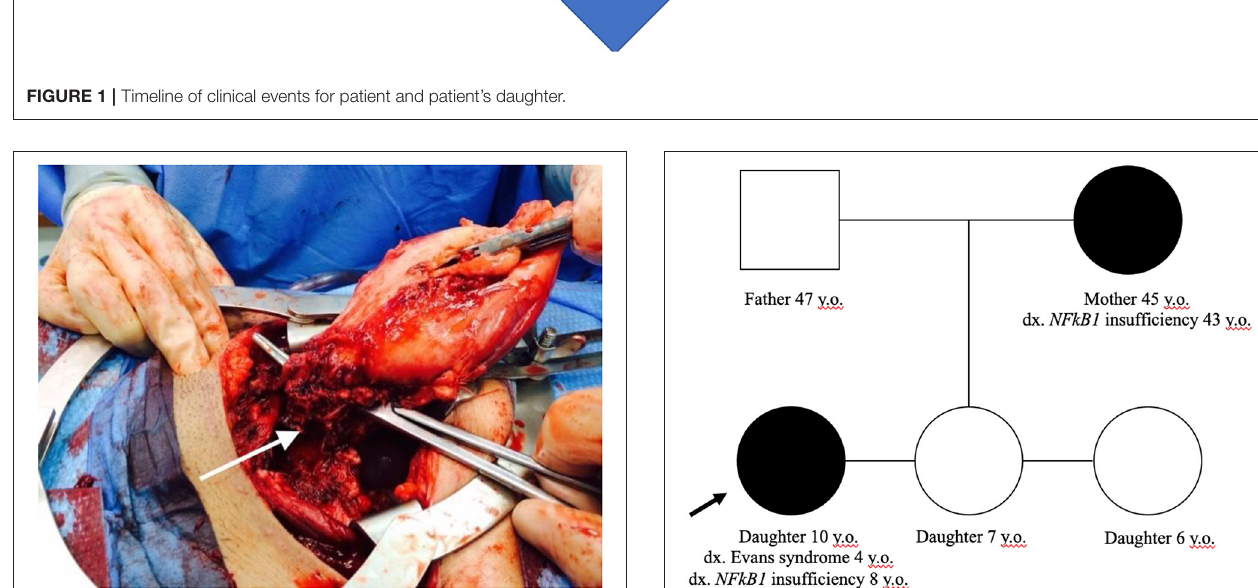
FIGURE 3 | Family pedigree. Only the mother and affected daughter harbor the NFkB1 (IVS2-2A > T; c.40-2A > T) variant. The father and other siblings have no evidence of altered